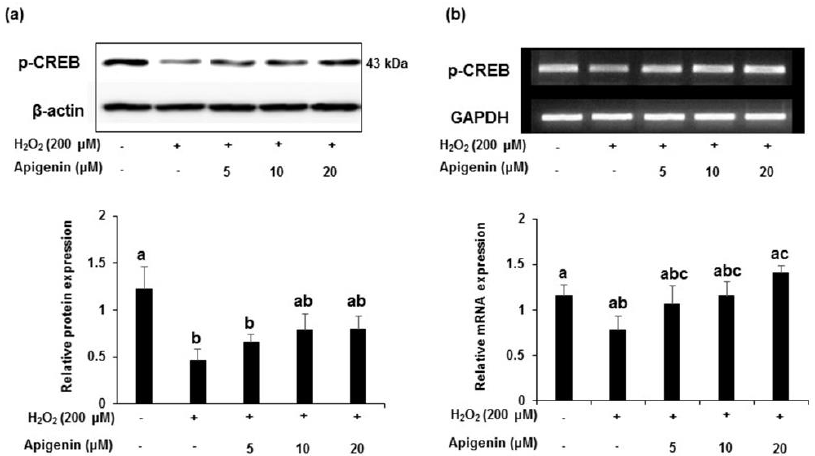
Figure 7. The effect of apigenin on the expression level of p-CREB in H 2 O 2 -exposed GC-2spd cells. ( a ) The protein expression level of p-CREB was analyzed using Western blotting. Cell lysates were immunoblotted with specific antibodies with Beta-actin as the internal control (upper panel) and the band intensity of p-CREB normalized to β -actin is shown in corresponding lower panel. ( b ) The mRNA expression of p-CREB was shown in upper panel and corresponding band intensities normalized to GAPDH was shown in lower panel. Data are expressed as the mean ± standard deviation ( n = 6). The groups of control, H 2 O 2 , and different concentrations of apigenin were compared with each other and letters on the top of the columns that do not share the same letters are statistically significant among the groups ( p < 0.05) by one-way ANOVA.